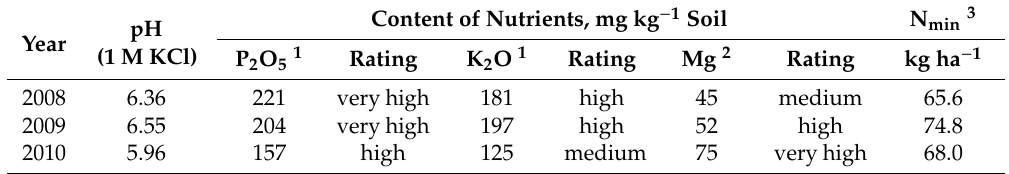
Table 1. Agrochemical characteristics of the soil in the research plots.